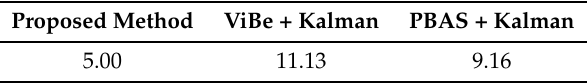
Table 7. Average OSPA values for all sequences.